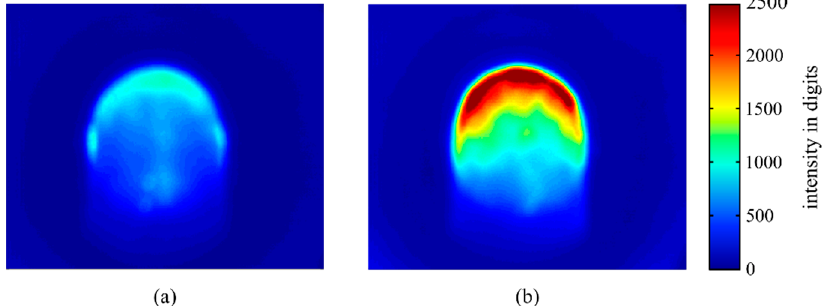
Figure 11. The average intensity distribution averaged over 10 frames in relation to ( a ) the lower NOP value range and ( b ) the upper value range recorded during the experiment at 𝑃 = 1400 W .